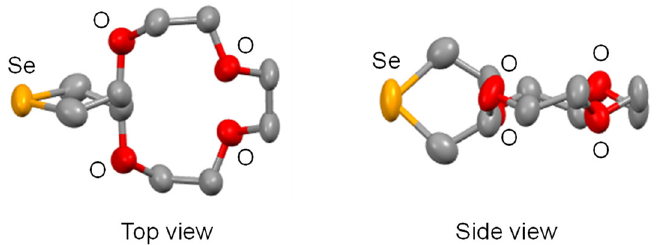
Figure 1. X-ray structure for DHS-crown-4 ( 1 ). Ellipsoids are drawn with 50% probabilities.